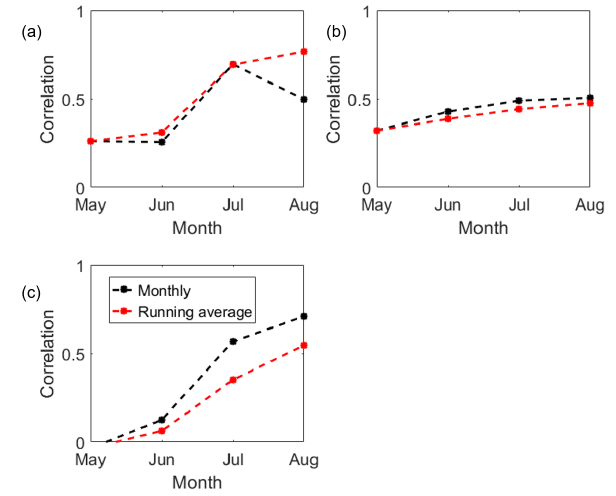
Figure 5. Temporal correlations of October–January streamflow and potential predictors: (a) precipitation, (b) Niño 3.4 sea surface temperatures, and (c) soil